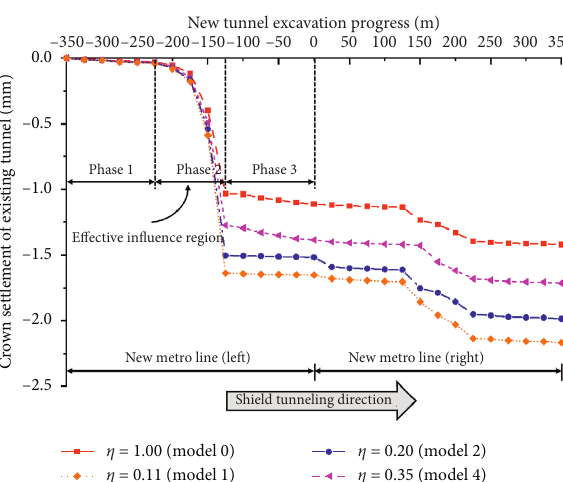
Figure 9: The time history curve of the crown maximum settle- ment of the existing tunnel towards the lower left corner. With the decrease of η in each model, the crown settlement of the convergence ellipse increases from 1.31 mm to 2.05 mm, and the convergence value increases from 1.45 mm to 2.12 mm. By comparing the monitoring data with each Model’s convergence ellipse of undercrossing section (as Figure 10), it is apparent that the results of model 4 is valid.